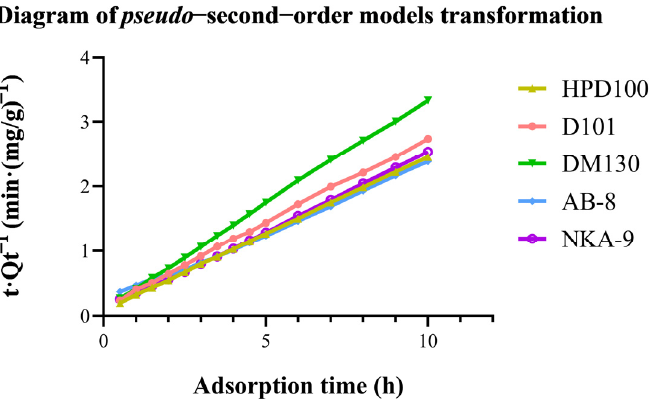
Figure 4. Diagram of pseudo − second − order models transformation. Table 2. Pseudo -first-order and pseudo -second-order model equations and dynamic